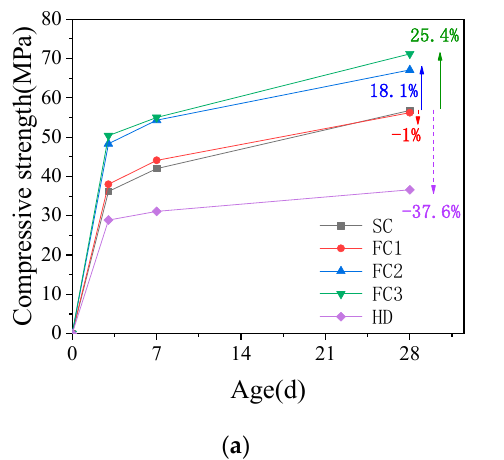
( b ) Figure 2. Strength of blank cement mortar (FA0-M), ( a ) Compressive strength and ( b ) Flexural strength. It can be seen from the Figure 2 that the strength under the condition of FC is higher than that under the condition of HD. The strength under the condition of FC1 is not im- proved compared with the condition of SC, but the strength under the conditions of FC2